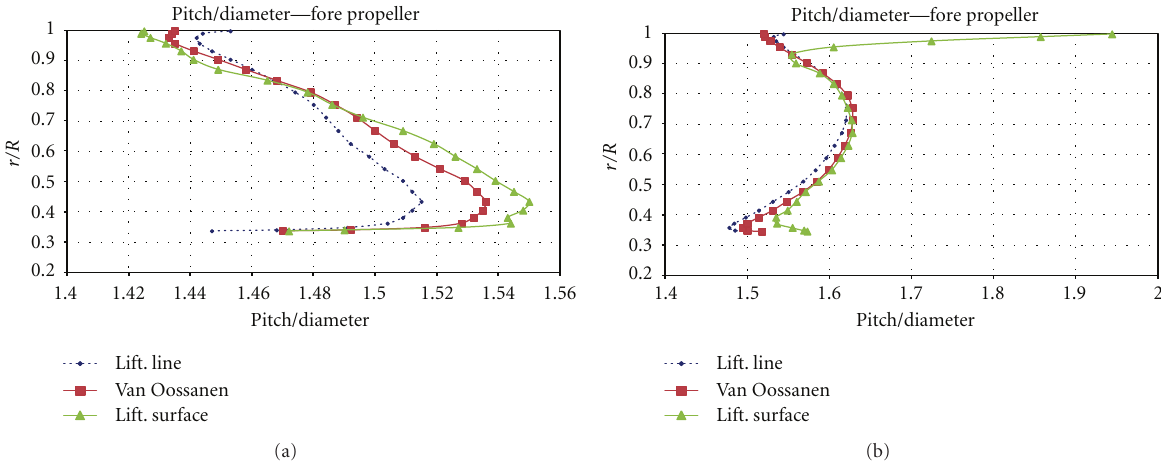
Figure 9: Pitch distribution on fore (a) and aft (b) propellers predicted with the l.l method, parametric (Van Oossanen) and numerical lifting surface corrections.